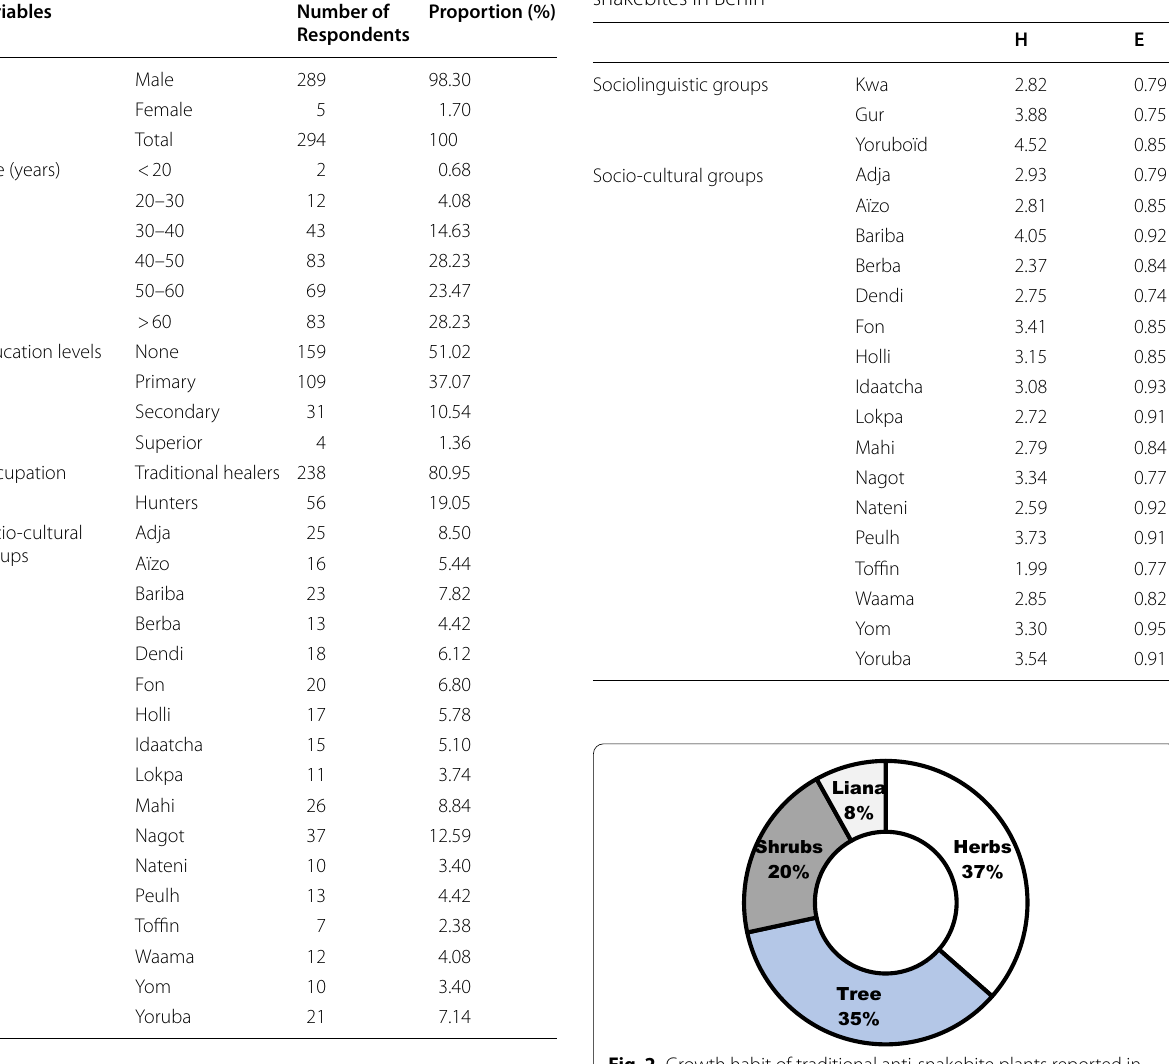
Fig. 2 Growth habit of traditional anti-snakebite plants reported in Bénin by the interviewed